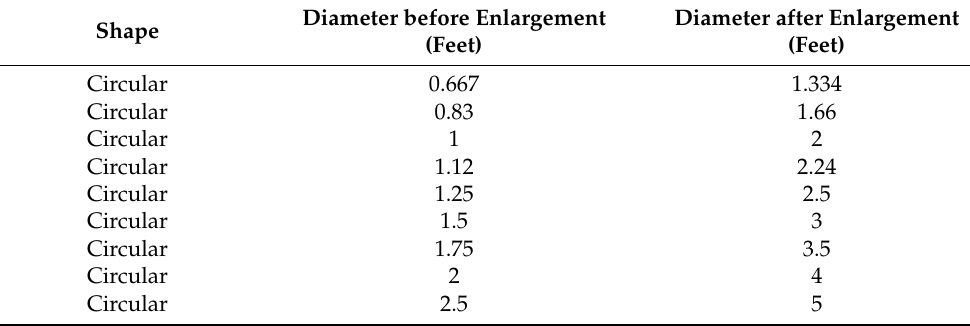
Table 2. Parameters of the pipe